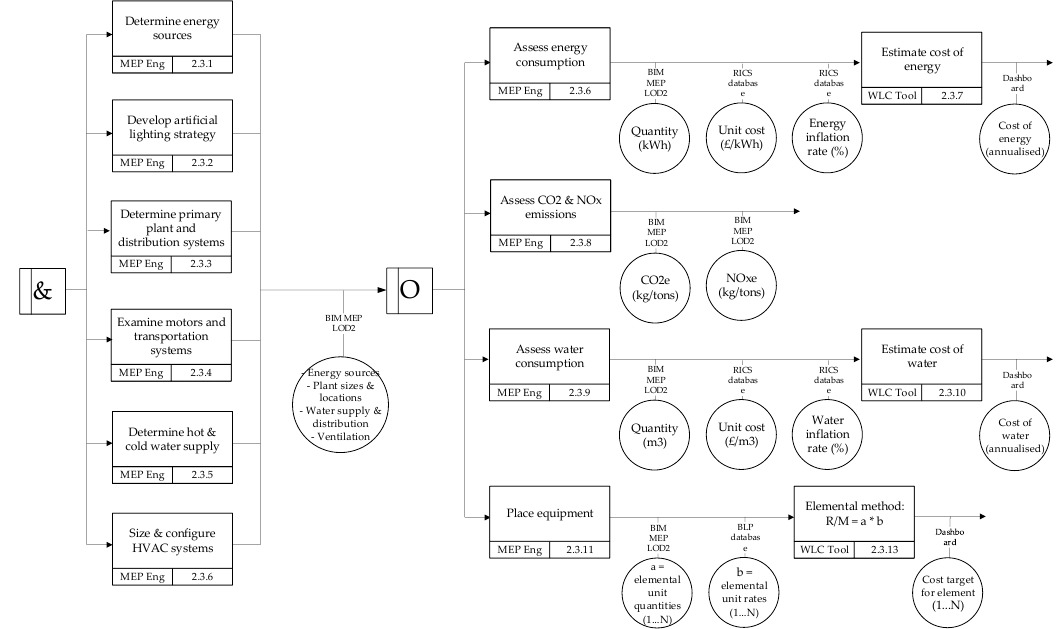
Figure 6. Detailed (Level 3) IDEF3 decomposition of UOB 2.3 “Mechanical services”.